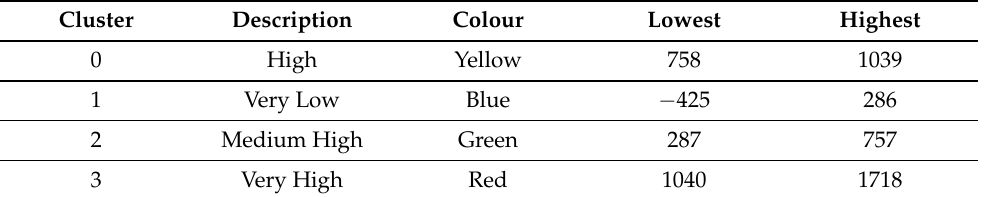
Table 1. Clusters’ elevation ranges and descriptions with K = 4.